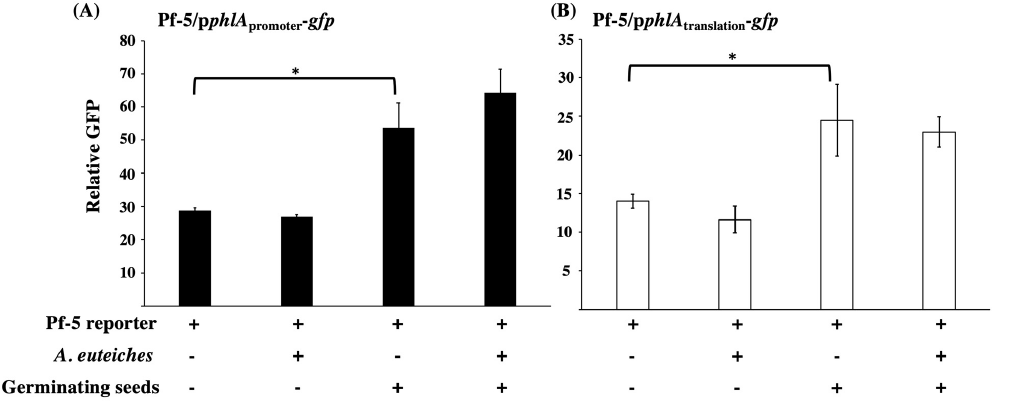
Figure 4. Expression of phlA by Pf-5 in the interactions with pea germinating seeds and A. eu- teiches . Wild type Pf-5 containing the GFP-based transcriptional reporter constructs p phlA promoter - gfp ( A ), or the translational reporter construct p phlA translation - gfp ( B ) was cultured with germinating pea seeds with or without the presence of A. euteiches hyphae. The expression of phlA was measured as relative GFP [fluorescence of GFP divided by (OD 600 × 1000)] recorded at 24 h post inoculation. * indicates treatments are significantly different ( p < 0.05), as determined by Student t -test. Data are